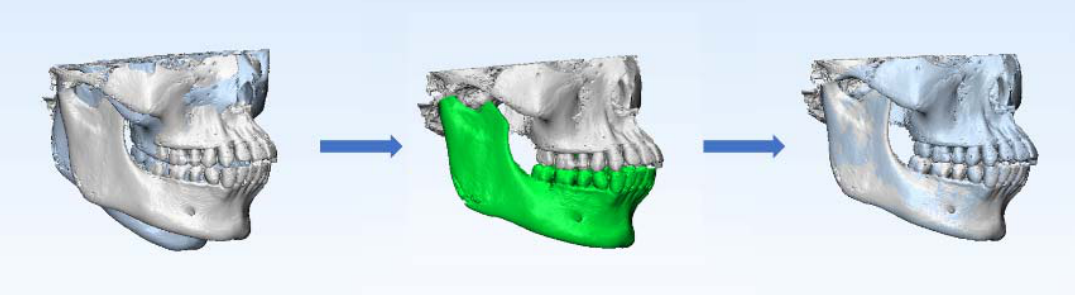
Figure 3. Process of mandibular voxel-based superimposition between T0 and T1. The white skull is the 3D model at T0. The blue skull is the 3D model at T1. The green area is the registration reference area of mandibular voxel-based superimposition.